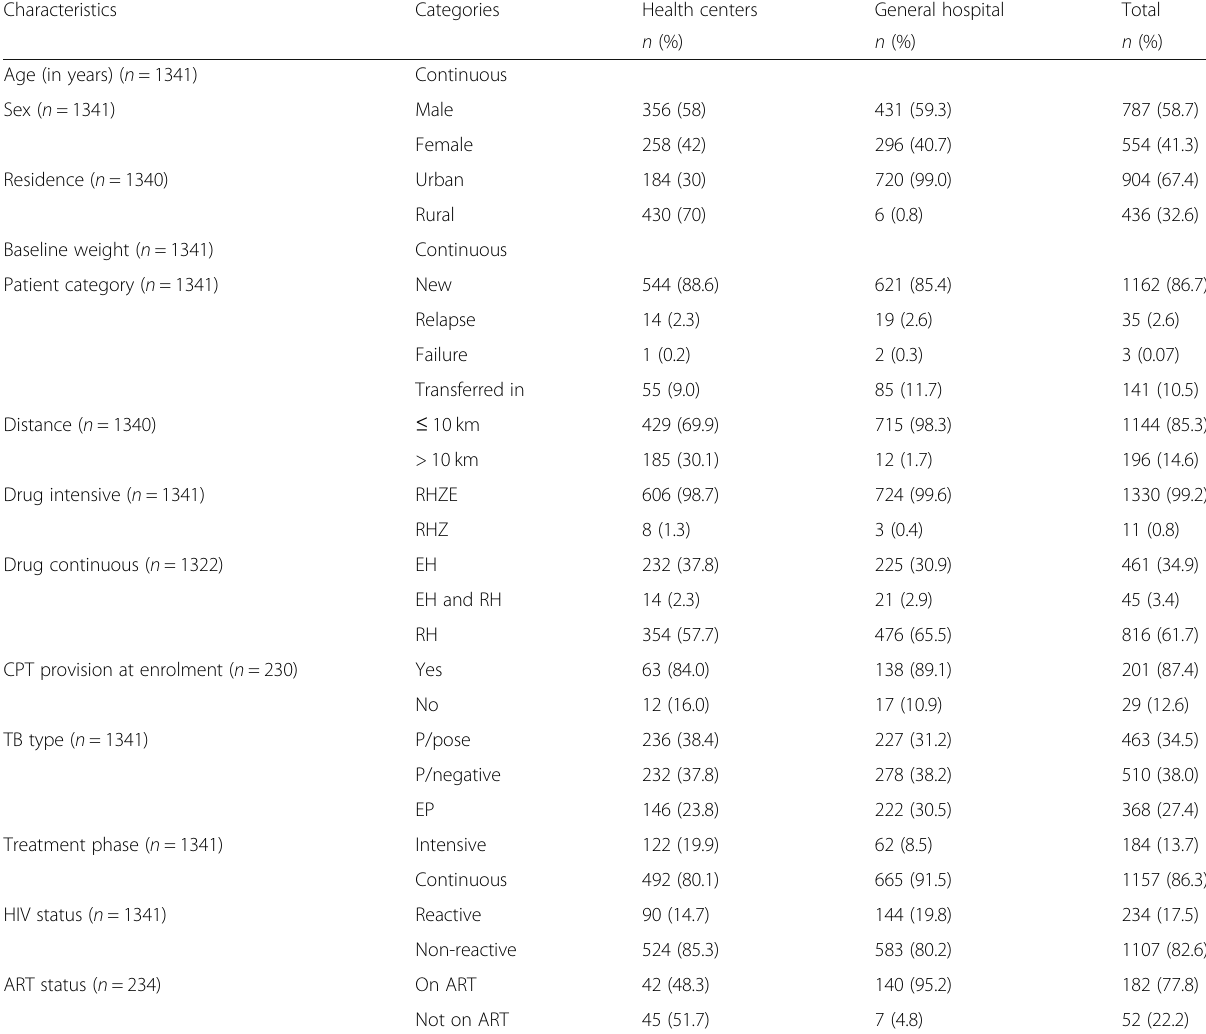
Table 1 Selected socio-demographic and clinical characteristics of 1341 TB patients enrolled into TB treatment and care at public health facilities, rural Ethiopia, during 2008 – 2015